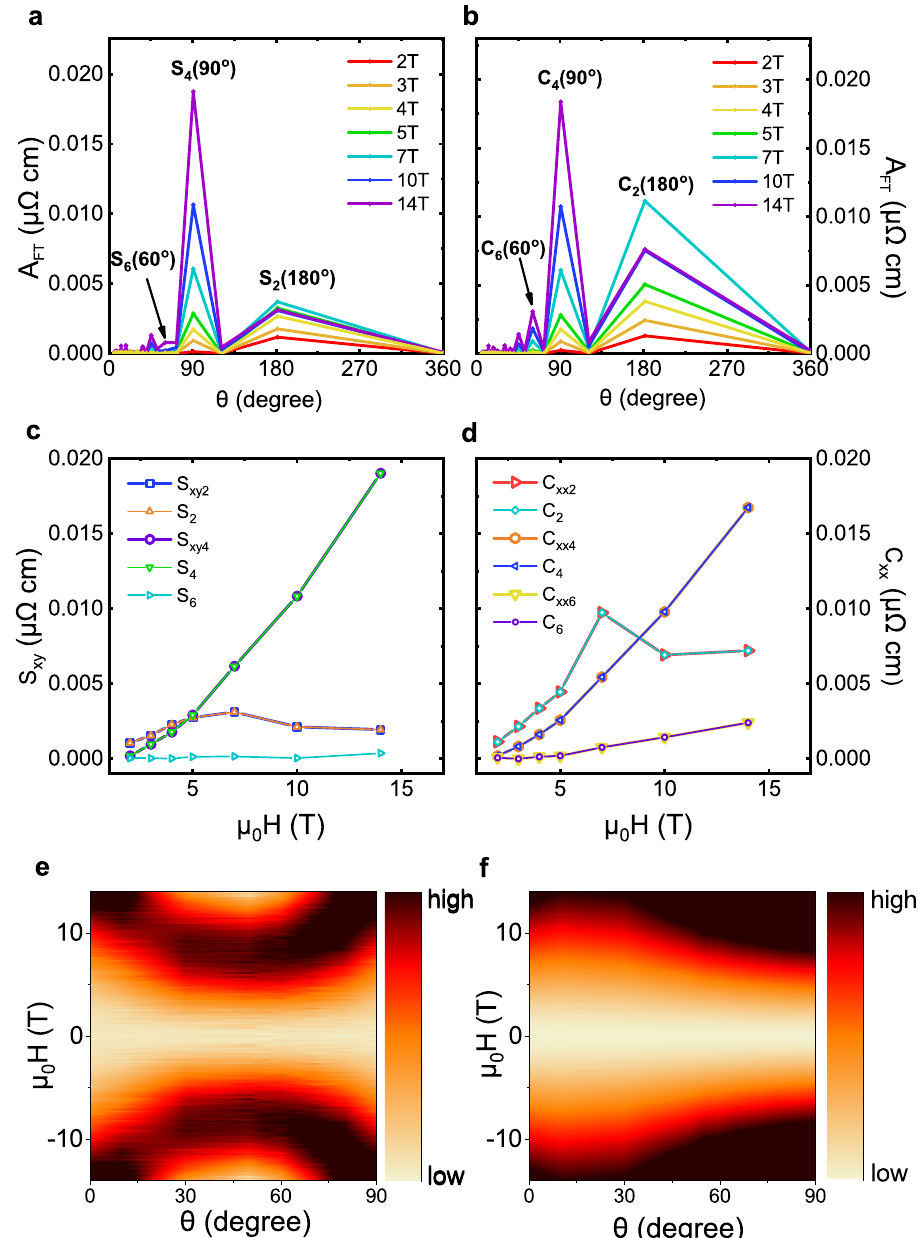
Fig. 3 The analysis of symmetry for oscillatory PHE and PAMR. a , b The Fast Fourier Transform (FFT) spectrum of ρ xy ( θ ) and ρ xx ( θ ) at 2 K with H = 2, 3, 4, 5, 7, 10, and 14 T. c , d The fi eld dependence of high-order oscillatory coef fi cients for PHE and PAMR. S μ 0 acquired from the amplitude of peaks of FFT spectrum of ( a , b ). S xy 2 , S xy 4 , C xx 2 , C xx 4 , and C xx 6 are acquired from the data fi tting for the formulas (3) and (4). e , f The color plots for fi eld dependent planar Hall and longitudinal resistivity ρ xy ( μ 0 H ) and ρ xx ( μ 0 H ) at the angles from 0 ∘ to 90 ∘ with the step of 10 ∘